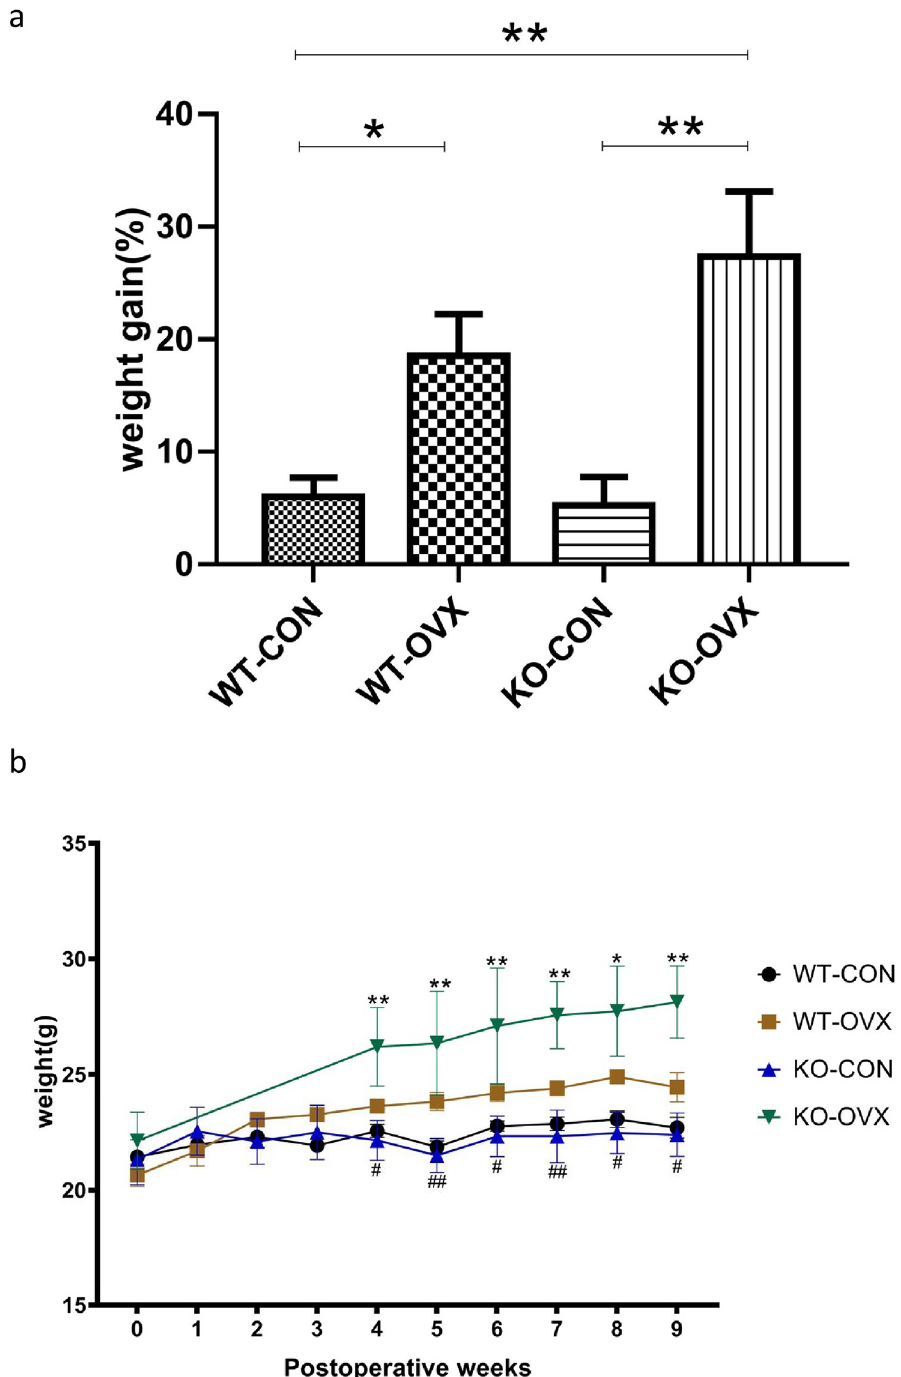
Fig 3. Changes in bodyweight in different groups of mice. WT-CON: wild-type control, WT-OVX: wild-type ovariectomy, KO-CON: Nrf2−/− control, KO-OVX: Nrf2−/− ovariectomy. (a) The weight gain in different groups of mice preoperatively and at postoperative week 9. � P < 0.05; �� P < 0.01. (b). Changes in bodyweight curve of different groups of mice during 9 weeks after ovariectomy. � P < 0.05; �� P < 0.01 (KO-OVX vs KO-CON); # P < 0.05; ## P < 0.01 (KO-OVX vs WT-CON). Results are shown as mean ± SEM. Data were analyzed by One-way ANOVA with Bonferroni’s Multiple comparison test.